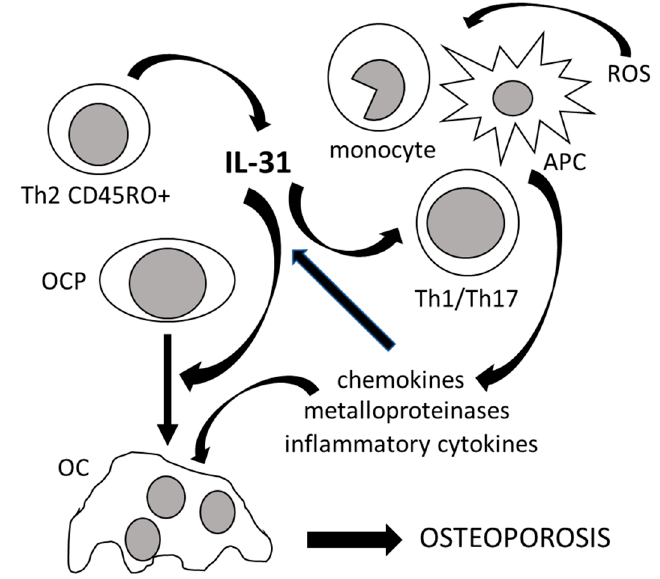
Figure 1. The role of IL-31 in bone remodeling. IL-31, mainly produced by T helper 2 memory cells (Th2 CD45RO+), promotes osteoclastogenesis by inducing the differentiation of osteoclast progenitors (OCP) into mature osteoclasts (OC). IL-31, in synergy with reactive oxygen species (ROS), also stimulates osteoclastogenesis indirectly by inducing antigen-presenting cells (APC), monocytes, and T helper 1 and 17 lymphocytes (Th1/Th17) to produce chemokines, metalloproteinases, and inflammatory cytokines, which in turn increase the production of IL-31. All of these events lead to the development of osteoporosis.